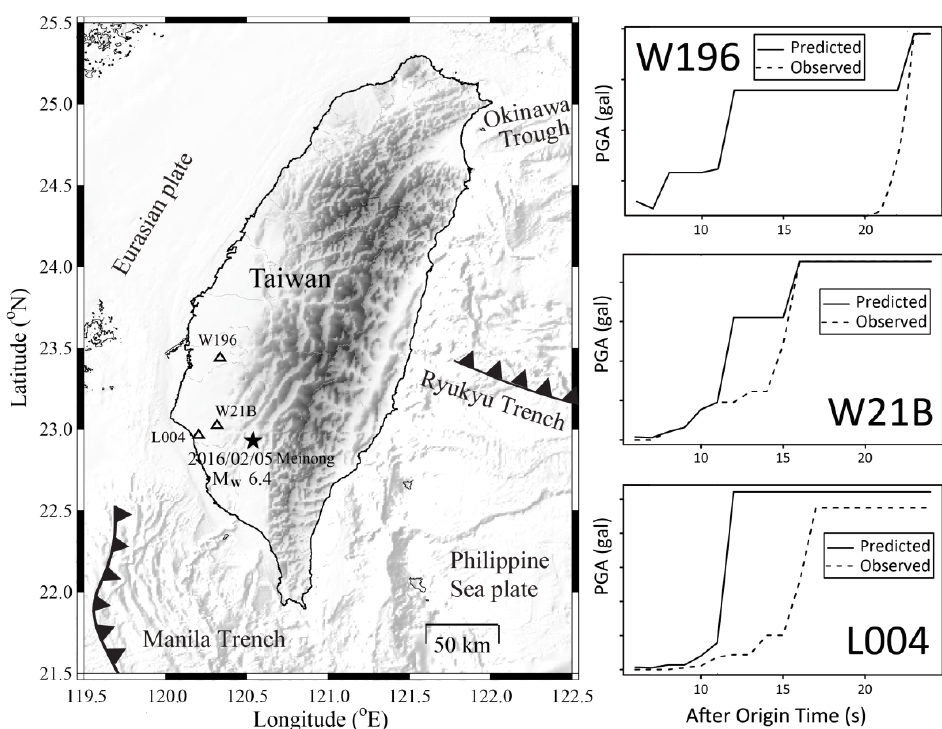
Figure 8. Predicted (solid) and observed (dash) PGA of three P-Alert stations of the 2016 Meinong earthquake. The predicted PGA by the ShakingAlarm approach. Stations W196, W21B, and L004 are 63, 27, and 35 km away from the epicenter, respectively.